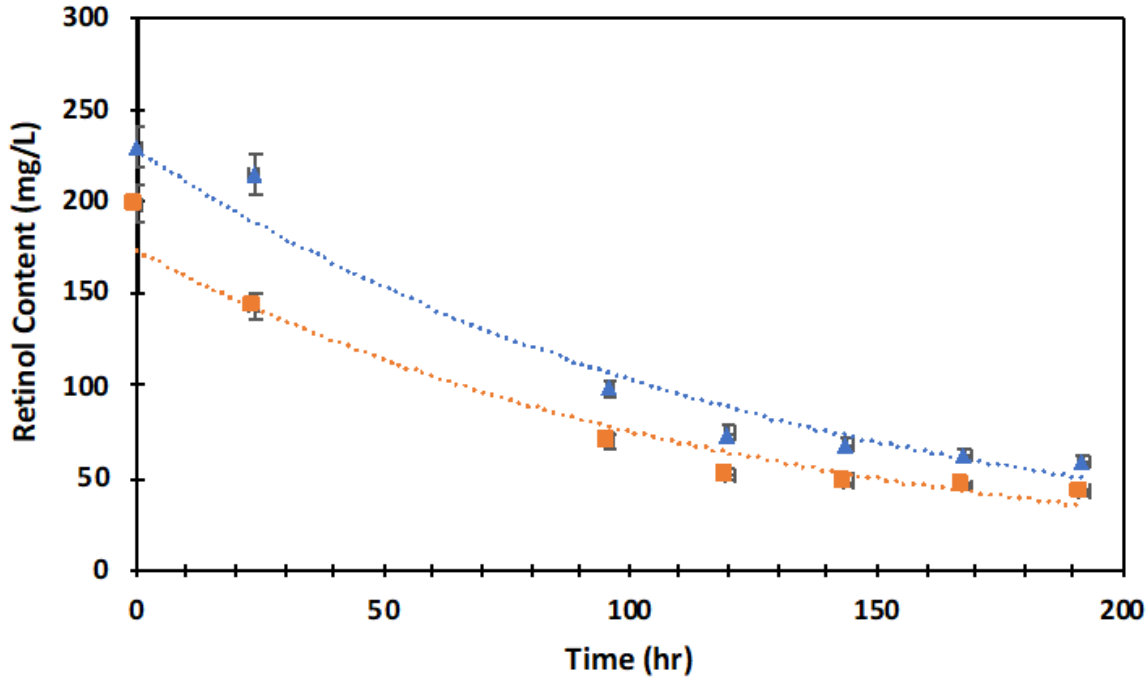
Figure 2. Retinol degradation as a function of the time for an aqueous solution of retinol (200 mg/L) (blue triangles) and a retinol (200 mg/L)-loaded PVA (150 g/L) hydrogel (orange square) incubated at 37 ◦ C. Retinol content was computed through the intensity of the absorbance at different periods. Discontinuous line represents exponential fit as RC = 228 e( − 0.008t) and RC = 173 e( − 0.008t) for the aqueous suspension and hydrogel, respectively. In both series of samples, retinol was degraded up to between 75 and 78% in 8 days of incubation at 37 ◦ C with a similar decay rate at − 0.008. RC = Retinol Content.